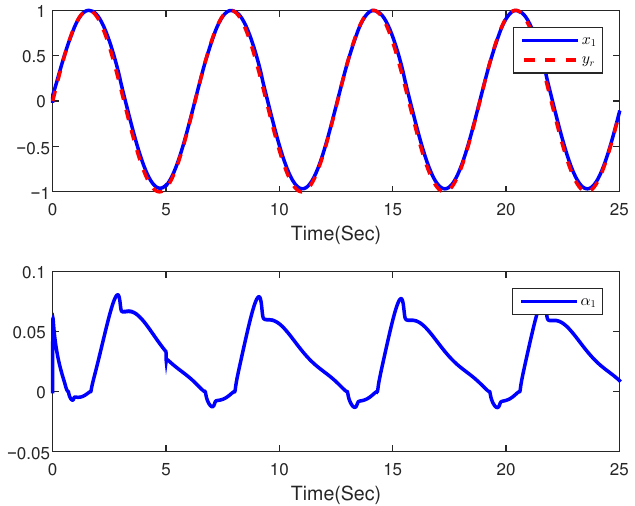
Figure 6. The output signal y and the desired signal y r , and the tracking error α 1 (Case